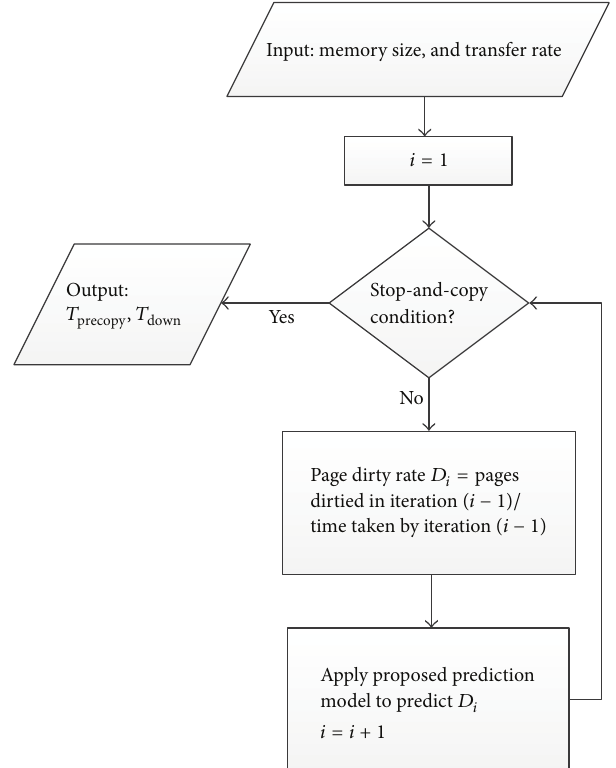
Figure 1: Improved precopy